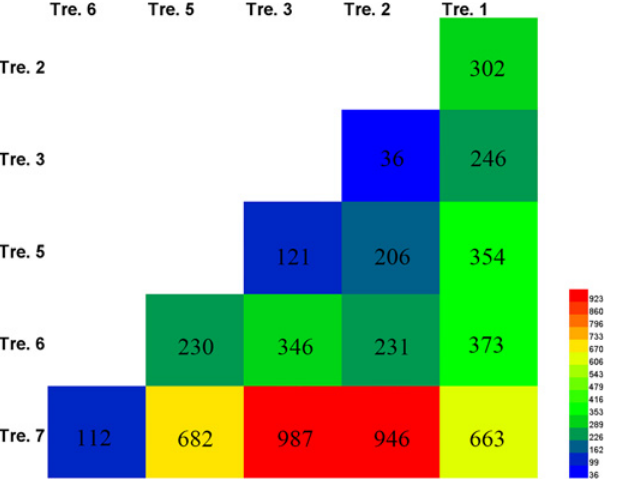
Fig 8. The number of DEGs derived from 15 pairwise comparisons of six